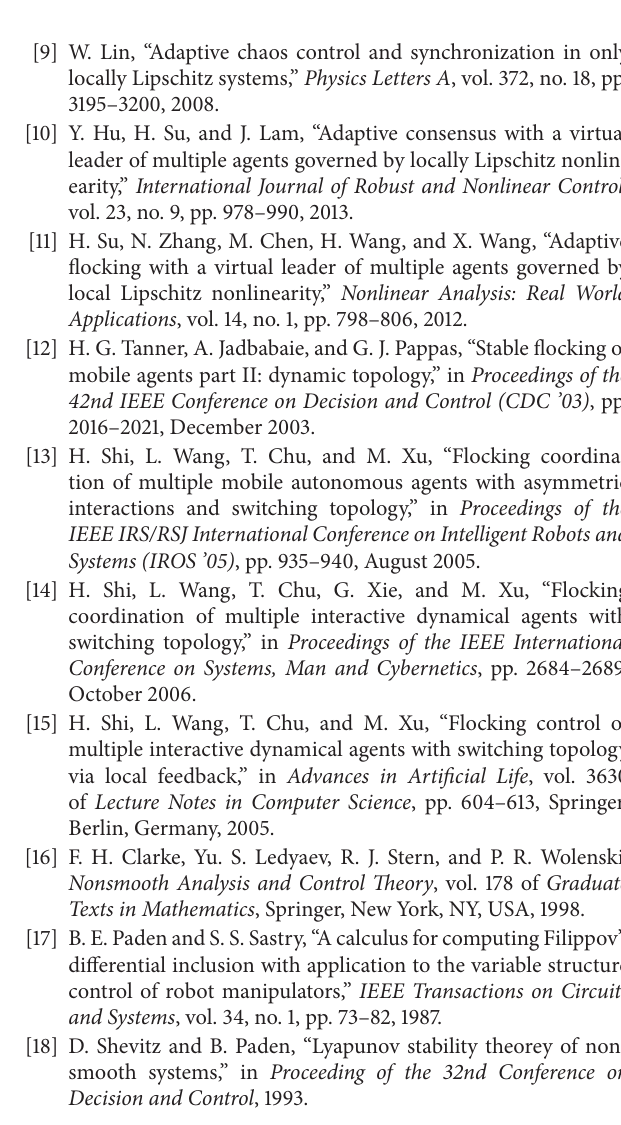
Figure 4: Convergence of the adaptive coupling strengths and the feedback